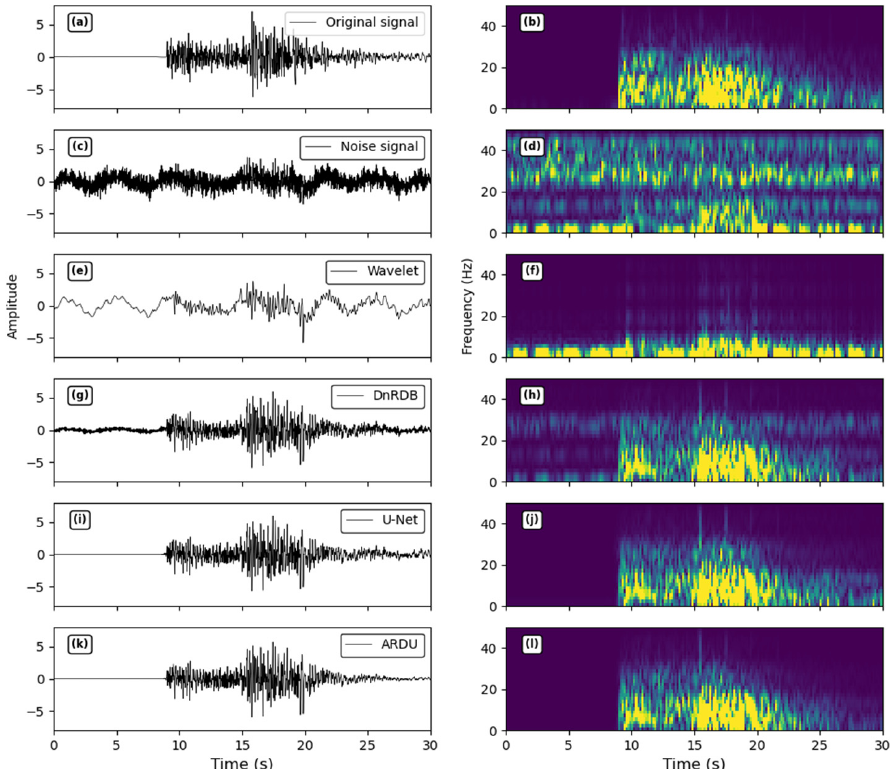
Figure 14. Denoising results of seismic signals with an SNR of 6 dB using different methods.